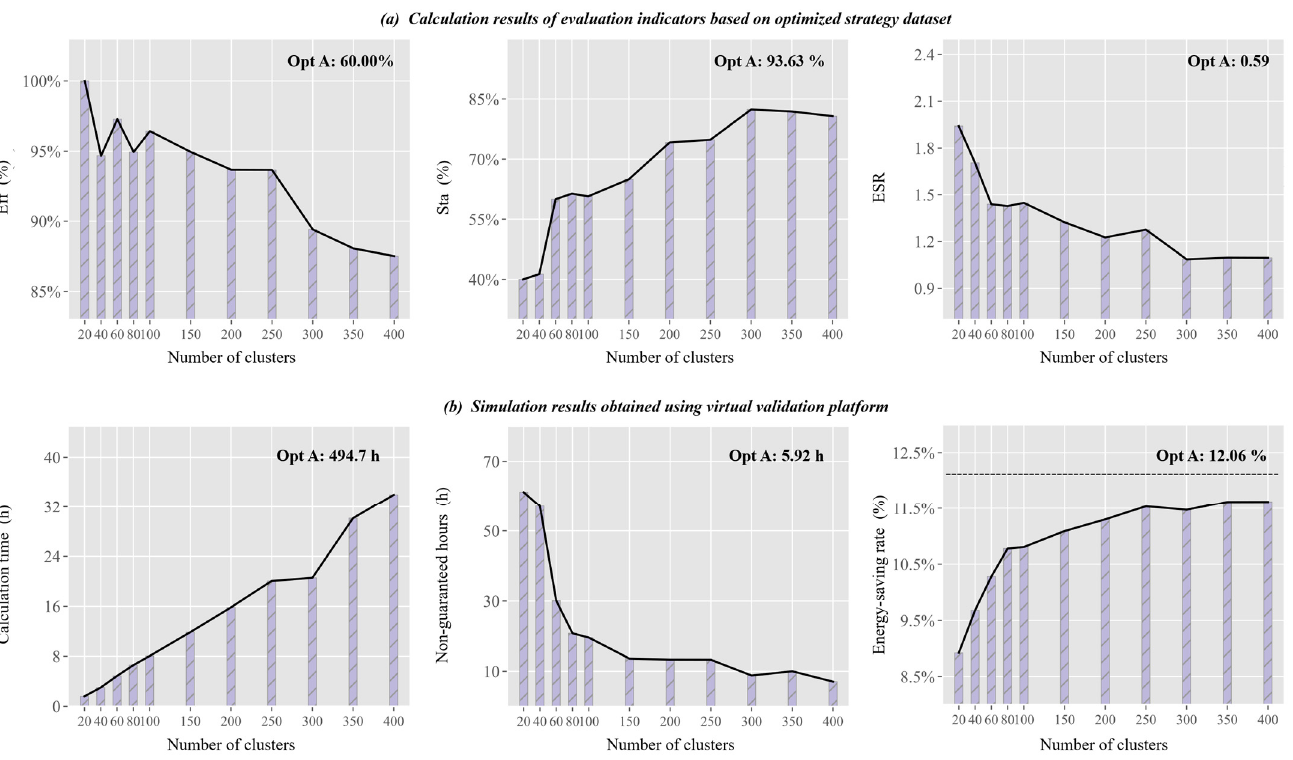
Figure 14. Changes of evaluation indicators and simulation results under di ff erent clustering numbers.